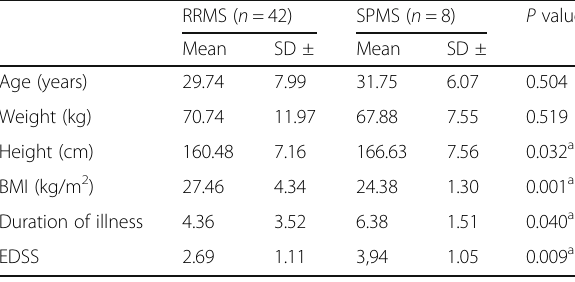
Table 1 Demographic and clinical data of patient